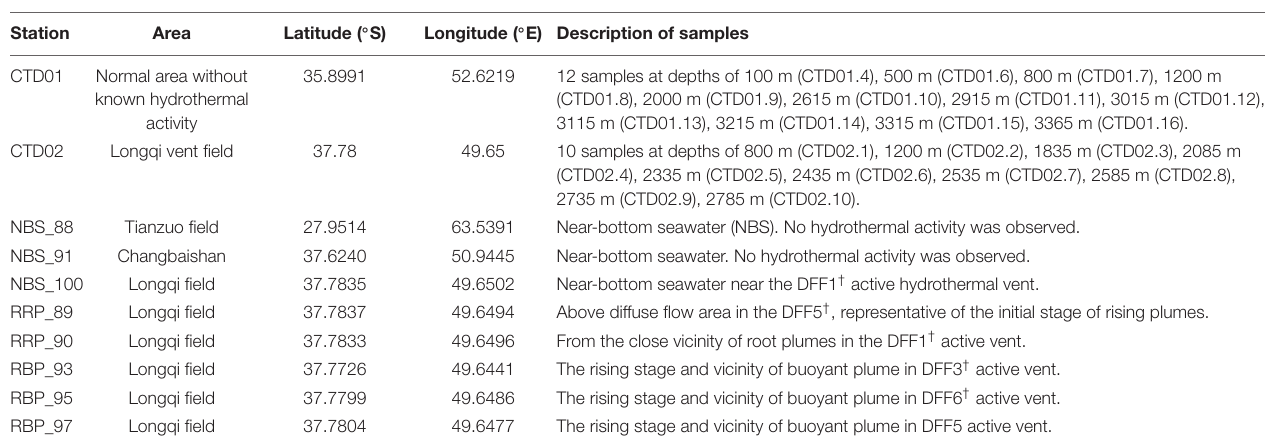
FIGURE 1 | Map of the research area and locations of sampling sites from the Southwest Indian Ridge (SWIR). (A) Location of research area on the Southwest Indian Ridge. SEIR, Southeast Indian Ridge. CIR, Central Indian Ridge. (B) Bathymetry map and location of the Longqi vent field (Tao et al., 2014; Li J. et al., 2016). (C) Locations of sample sites in Longqi vent field and other areas (insert). TABLE 1 | The detailed information of samples collected for this